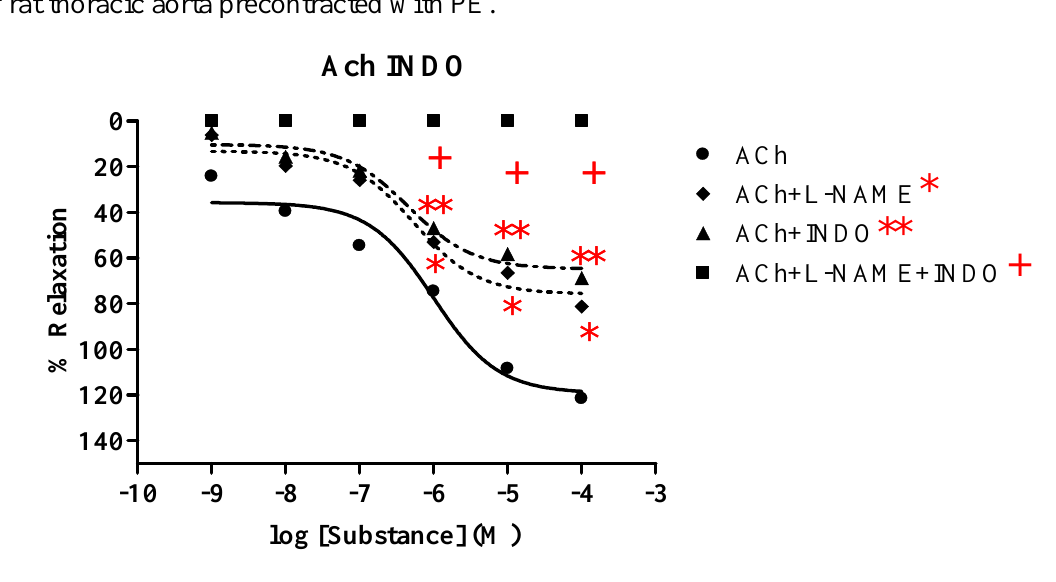
Data represent as means ± s.e.m. of 5 experiments, each performed in duplicate.